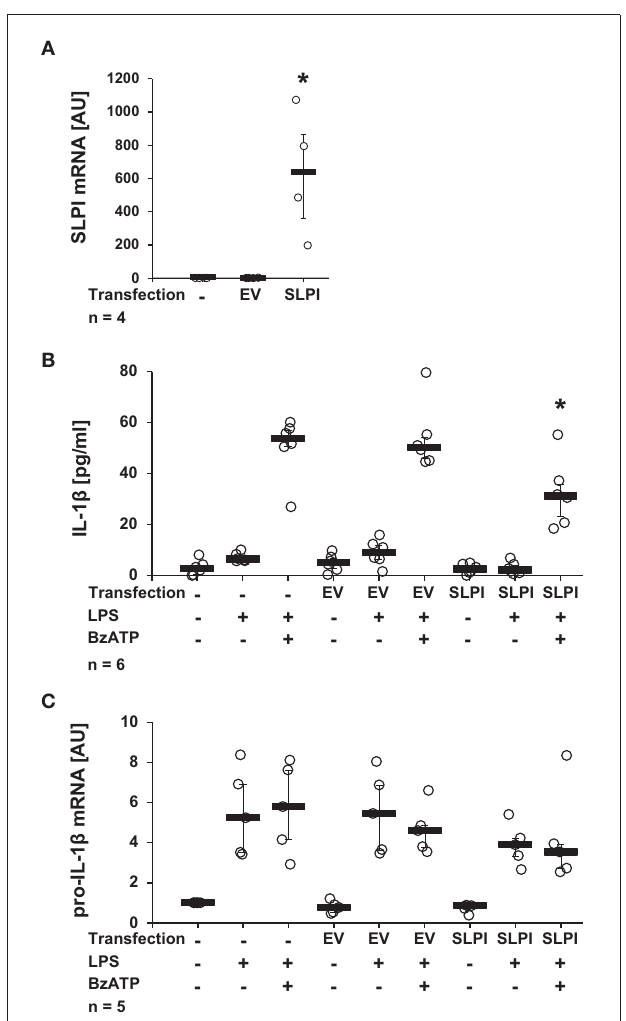
FIGURE 3 | Overexpression of SLPI reduces the BzATP-mediated IL-1 β release by U937 cells. Human monocytic U937 cells were left untreated, transfected with the empty vector (EV), or with an expression vector containing the coding sequence for human SLPI (SLPI). Twenty-four hours after transfection, the cells were primed with LPS (1 µ g/ml, for 5h) and further stimulated with 2 ′ (3 ′ )-O-(4-benzoylbenzoyl)adenosine 5 ′ -triphosphate triethylammonium salt (BzATP; 100mM) for 30min. The concentration of IL-1 β in cell culture supernatants was measured by ELISA. The mRNA expression of SLPI or pro-IL-1 β was assessed by real-time PCR. (A) Transfection with SLPI expression vector increased the mRNA level of SLPI compared to cells transfected with EV. (B) The BzATP-induced IL-1 β release was significantly lower in cells overexpressing SLPI compared to cells transfected with EV. (C) The mRNA level of pro-IL-1 β was not affected by SLPI overexpression; * p ≤ 0.05 significantly different compared to cells transfected with EV (A) or transfected with EV and stimulated with LPS and BzATP (B,C) . Experimental groups were compared by Kruskal-Wallis test followed by Mann-Whitney rank sum test.